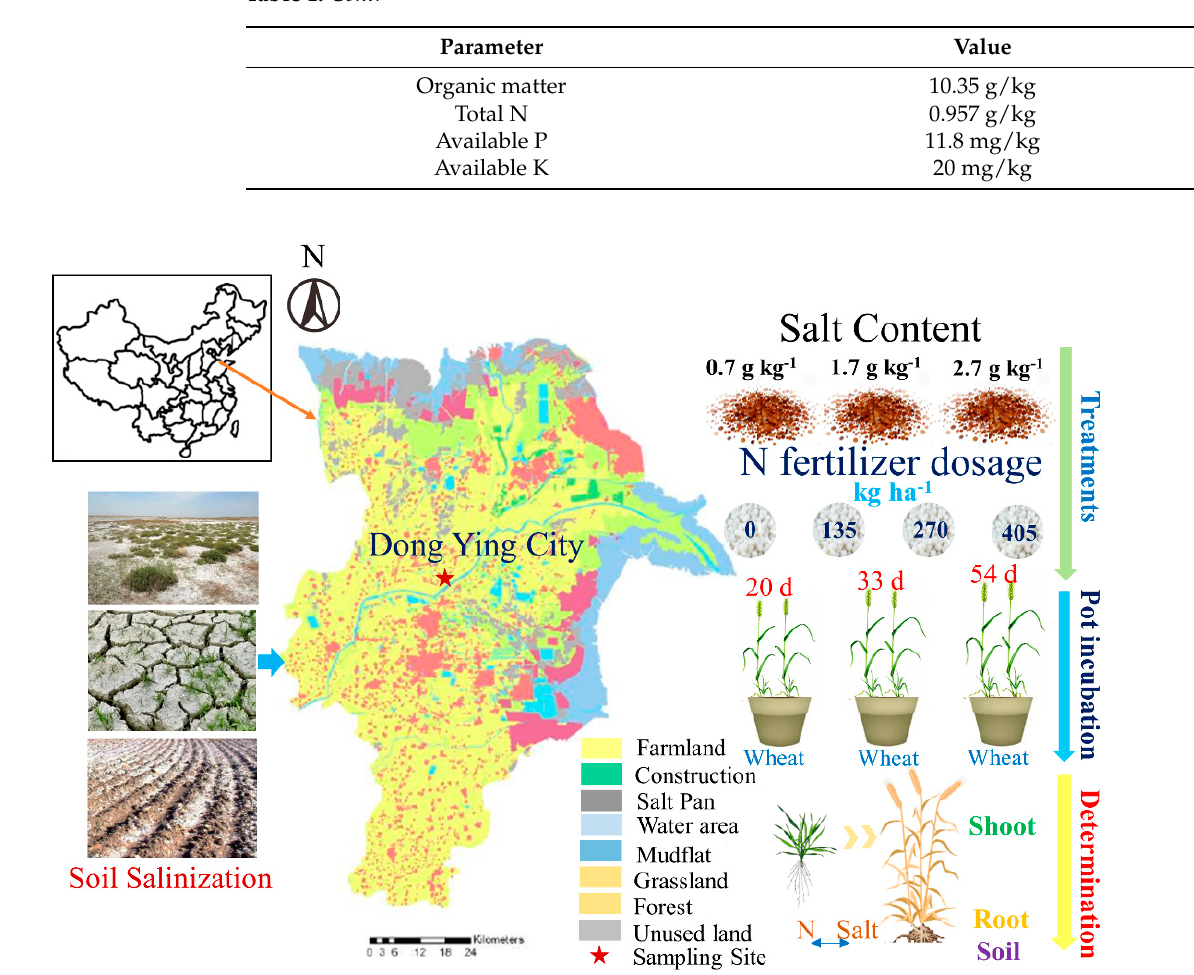
Figure 1. The sampling site and experimental design.